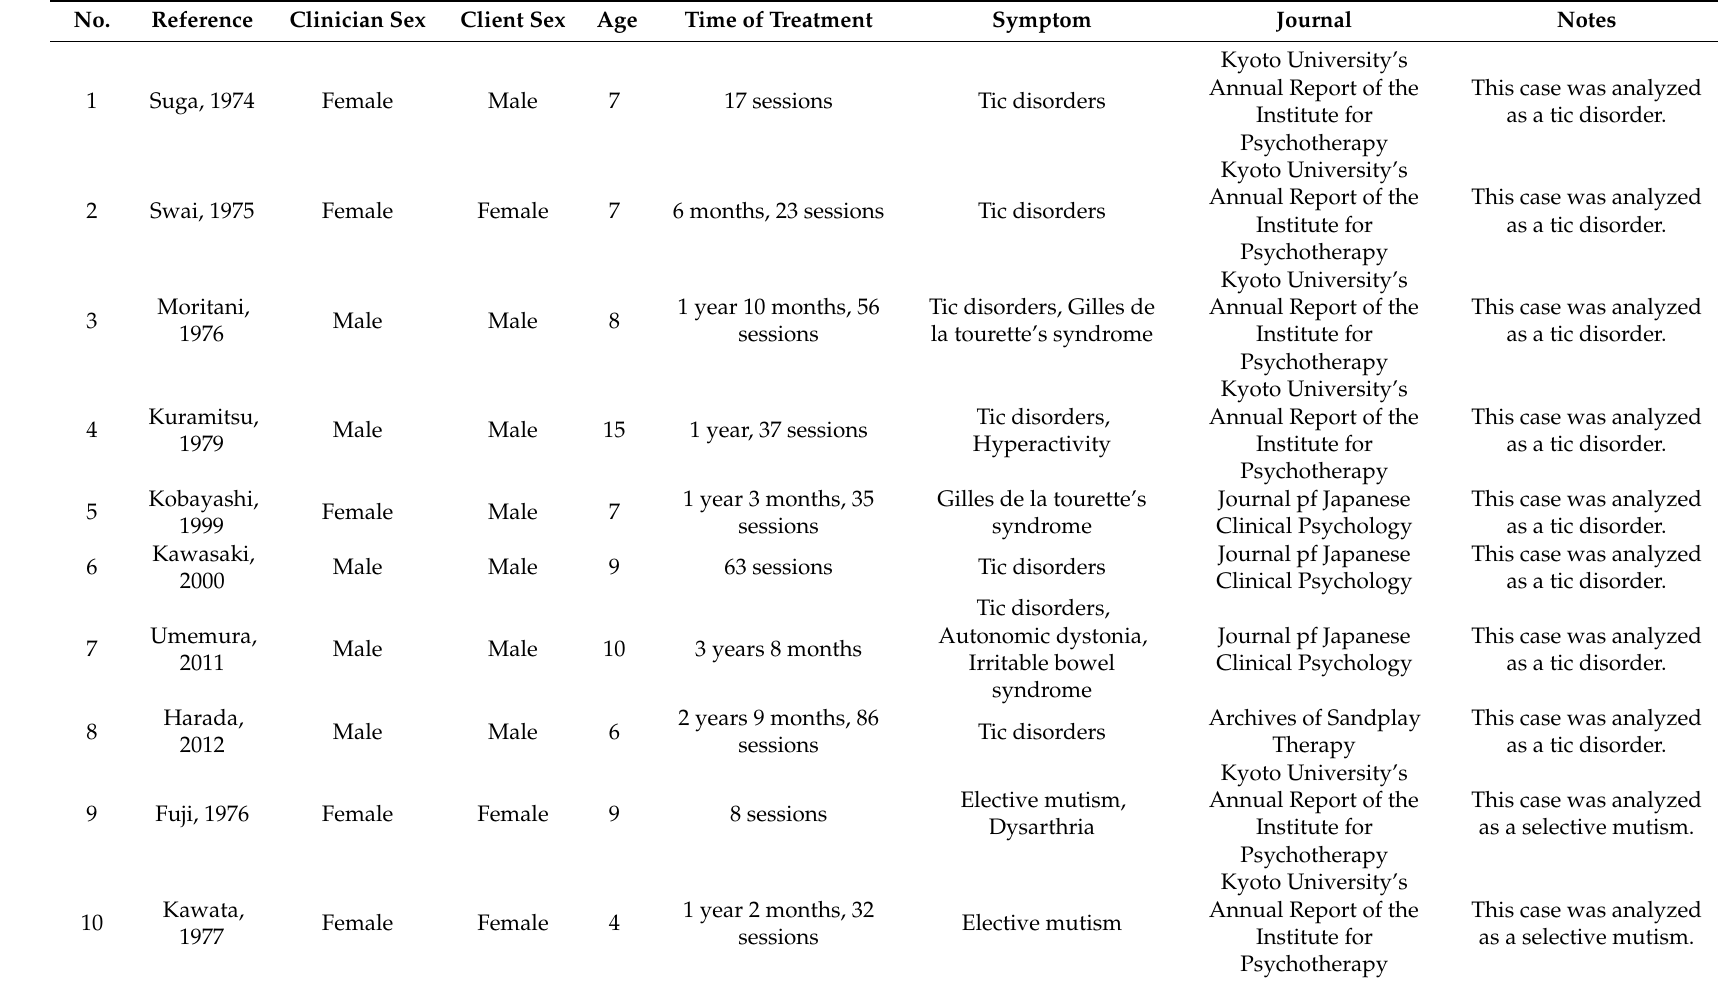
Table 2. Summary of case studies included in the